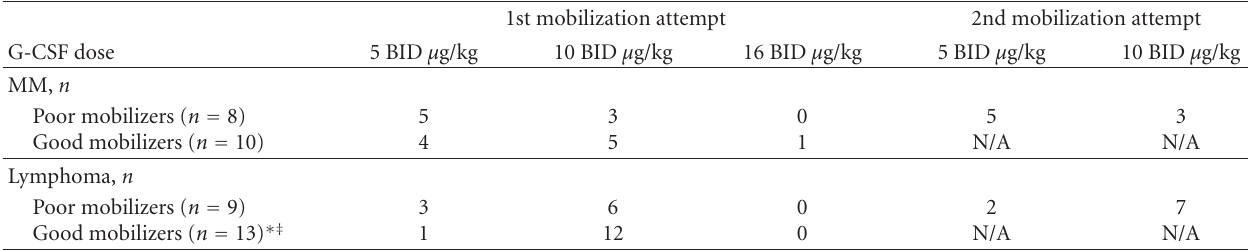
Table 3: The mobilization regimens used except when nonapplicable (N/A). Plerixafor dose was 0.24 mg/kg for all patients given at 2200 the night before apheresis.